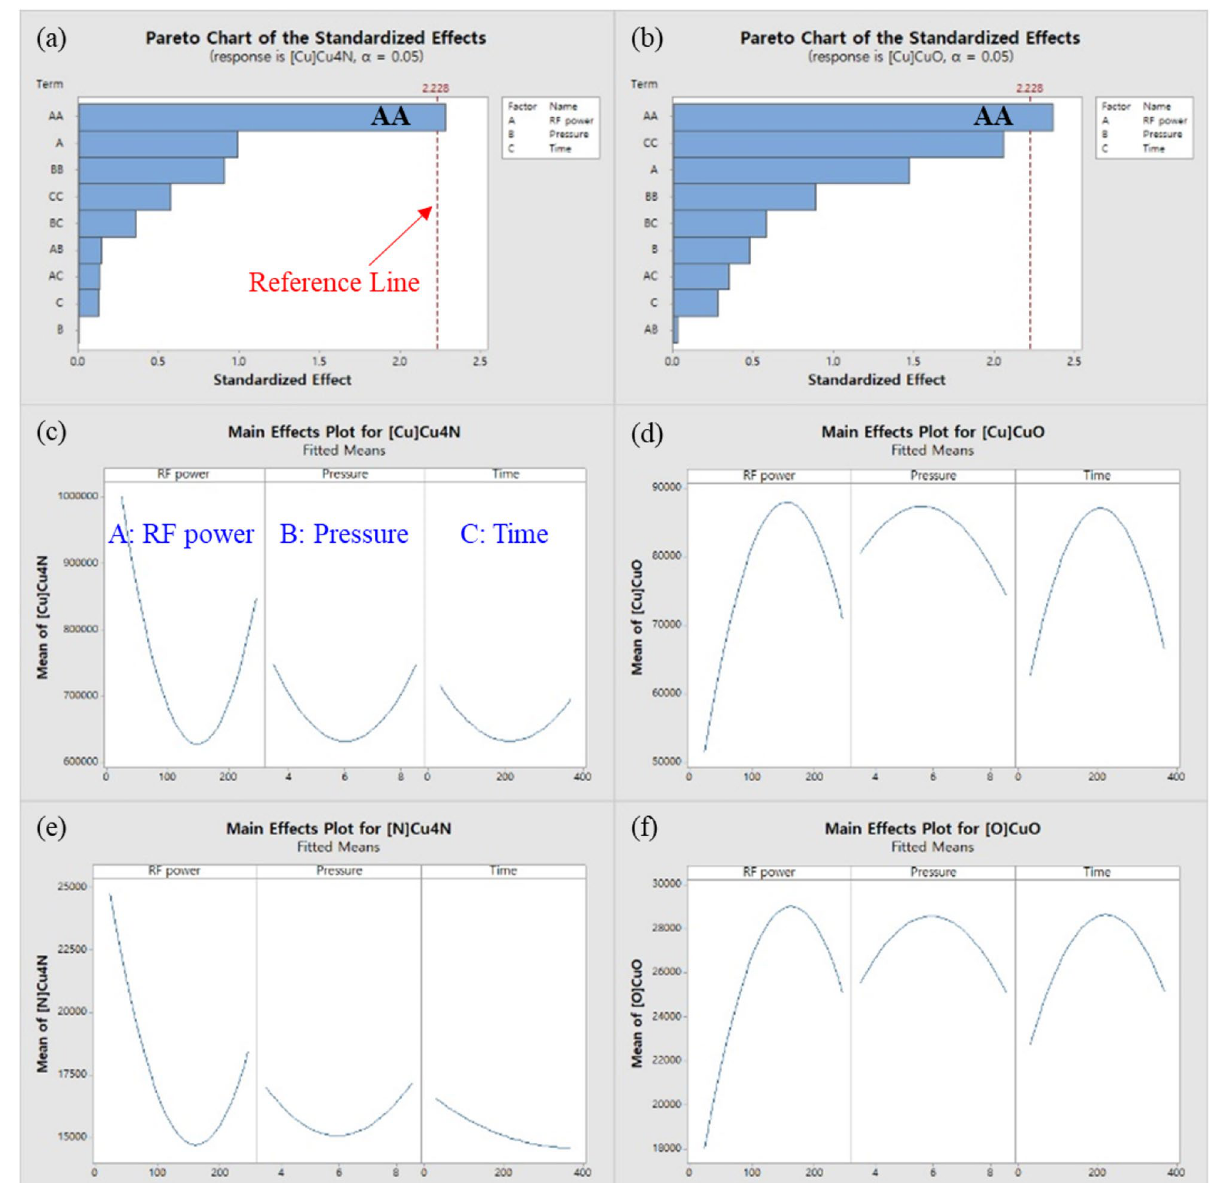
Figure 3. Analysis of the response surface design at 95% confidence level using a Minitab program ( a ) the Pareto chart of the standardized effects for the Cu 4 N peak of the Cu2p 3/2 , and the place where the term crosses the reference line is statistically significant, ( b ) the Pareto chart of the standardized effects for CuO peak of the Cu2p 3/2 , and ( c - f ) the main effects plot calculated by the response for Cu 4 N and CuO in the Cu2p 3/2 , O1s, and